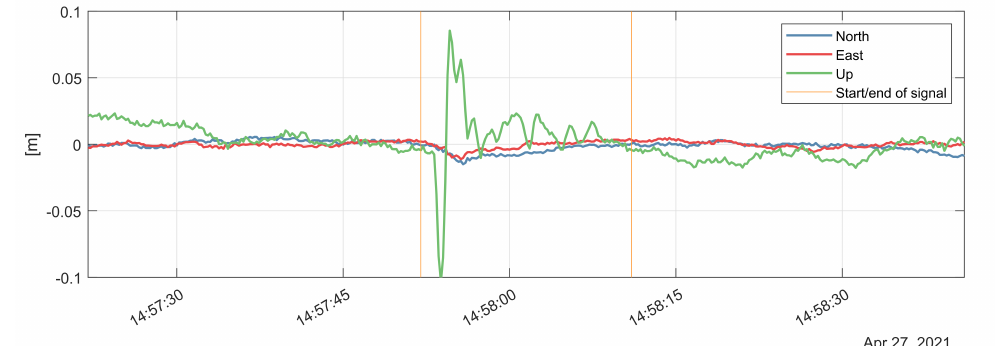
Figure 9. Session 1: results for the dynamic tests with the seismic strong-motion waveforms (u-blox F9P logger and JAVAD